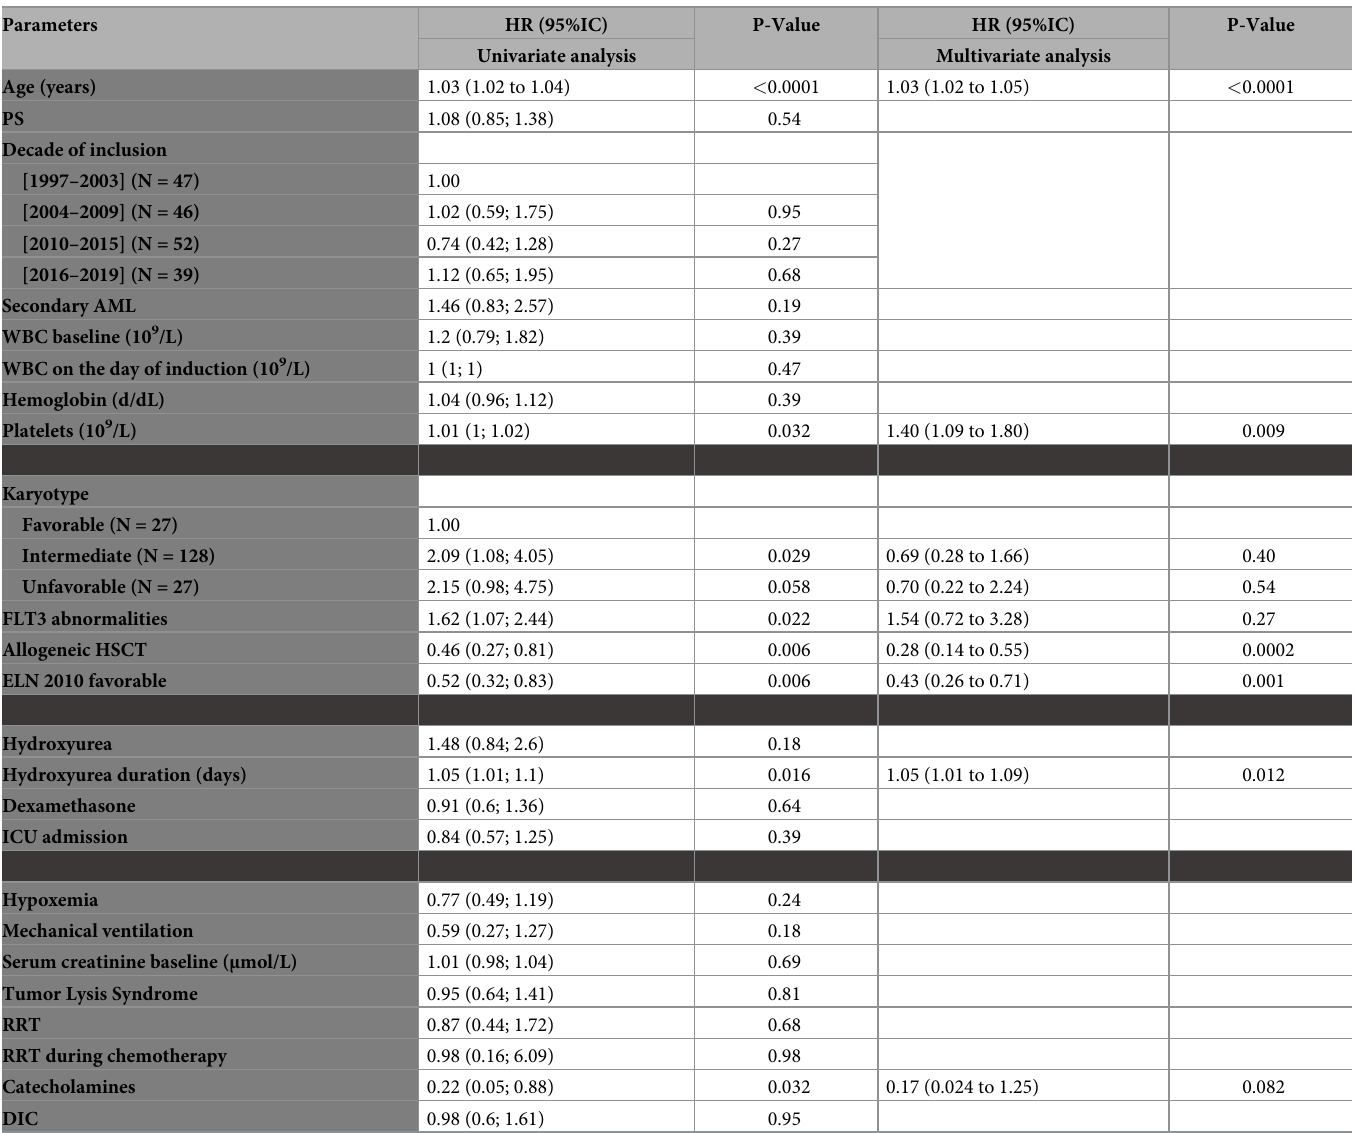
Table 2. Univariate and multivariate analysis of relapse